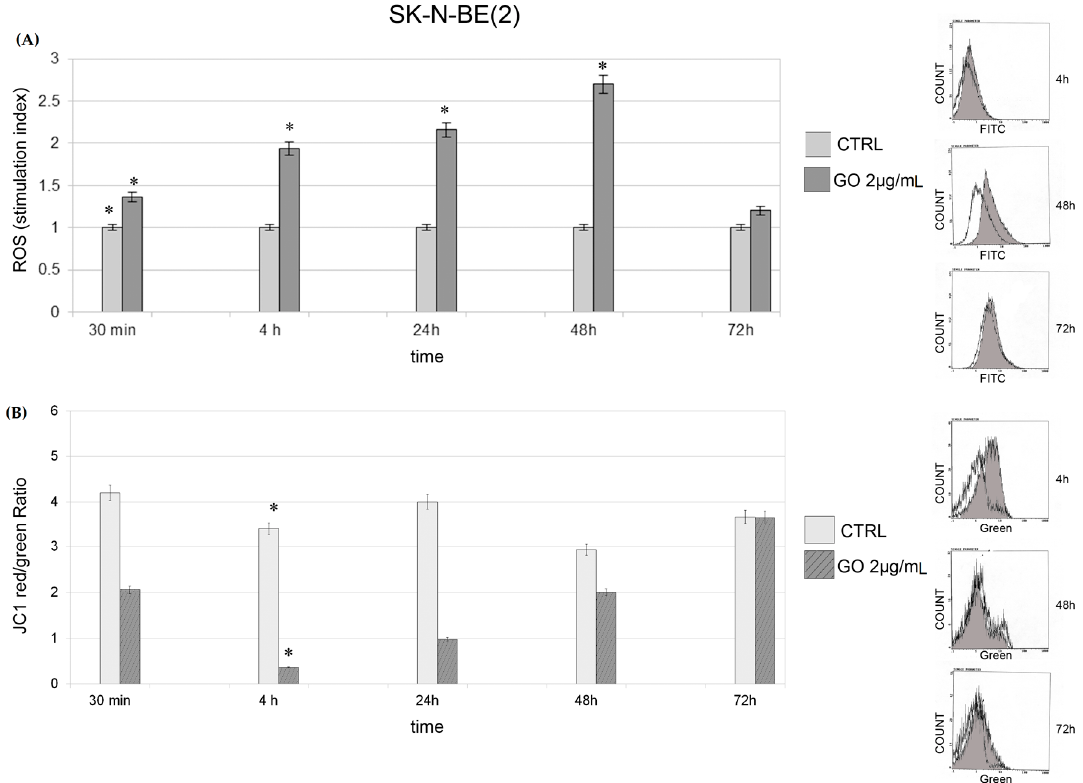
Figure 3. Reactive oxygen species (ROS) production and JC1 dye in SK-N-BE(2) cells: ( A ) ROS production in SK-N-BE(2) cells at different times of GO exposure The mean fluorescence intensity was detected and expressed as stimulation index obtained by ratio between ROS levels in treated cells divided by ROS in control cells. Data are the mean ± SD of three different experiments. * p < 0.05 for each exposure condition compared to unexposed control (CTRL). On the right of the panel, there are indicative fluorescence peaks (FITC) of control cells and GO treated cells at indicated times. Grey peaks refer to GO treated cells. ( B ) JC1 dye in SK-N-BE(2) cells at different times of GO exposure. Data are expressed as mean of red/green ratio of three different experiments ± SD. On the right of the panel, there are indicative peaks of green fluorescence (referring to depolarized cells) of control cells and GO treated cells at indicated times. Grey peaks refer to GO treated cells. * p < 0.05 for each exposure condition compared to unexposed control (CTRL).